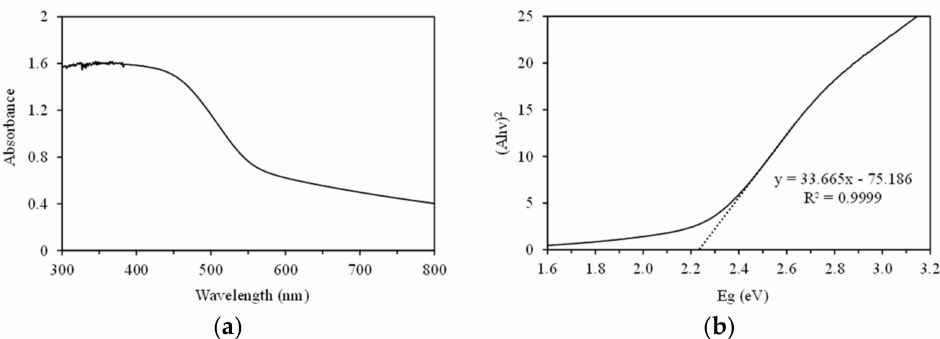
Figure 3. ( a ) UV–vis diffuse reflectance spectrum of the as-prepared SnIn 4 S 8 photocatalyst; ( b ) Plots of ( α h ν ) 2 versus energy (h ν ) for calculating the band gap energy.